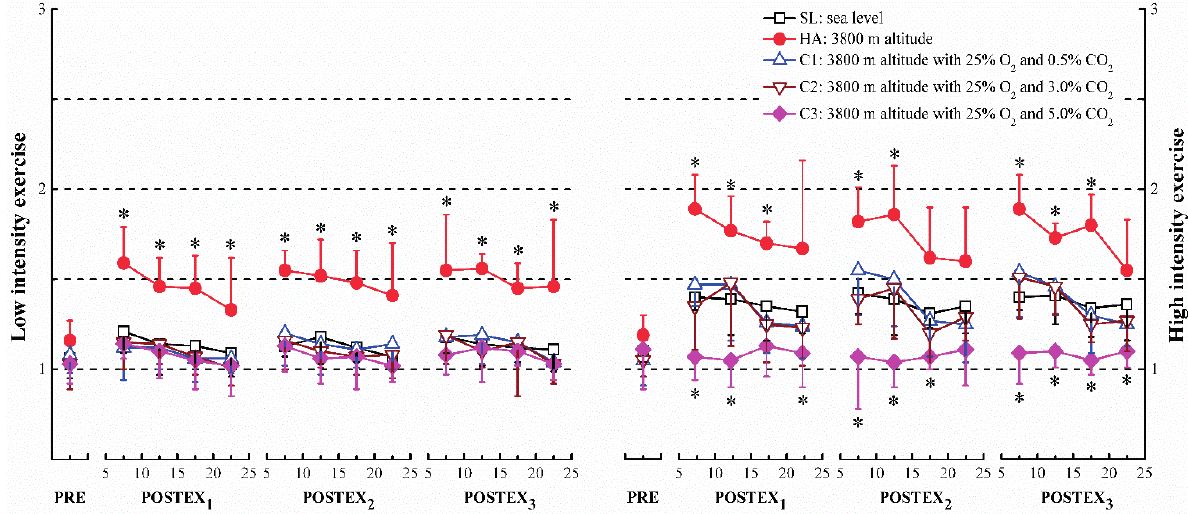
Figure 5. The ratios of low frequency/high frequency (LF/HF) in pre-exercise (PRE) and post-exercise (POSTEX 1 , POSTEX 2 and POSTEX 3 ). * p < 0.05, compared with SL in the same segment and exercise